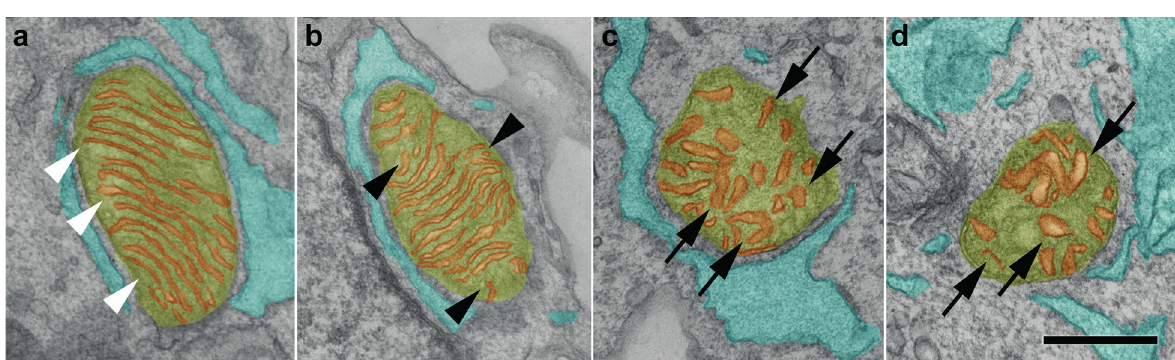
Figure 1 - Mitochondrial cristae are affected after VPA treatment. ( a ) Transmission electron microscopy showed that control cells presented regular distribution of thin and parallel oriented cristae in mitochondria (white arrowheads). Mild alterations were seen after 0.01 mM VPA treatment ( b ) (black arrowheads) and high degree of cristae disorganization and swelling after 0.1 and 1 mM VPA treatment ( c and d ) (arrows). Endoplasmic reticulum was also seen in close contact with mitochondria in all conditions (ER). Inter membrane space: yellow; cristae: orange and endoplasmic reticulum: blue. Bar = 1µm.